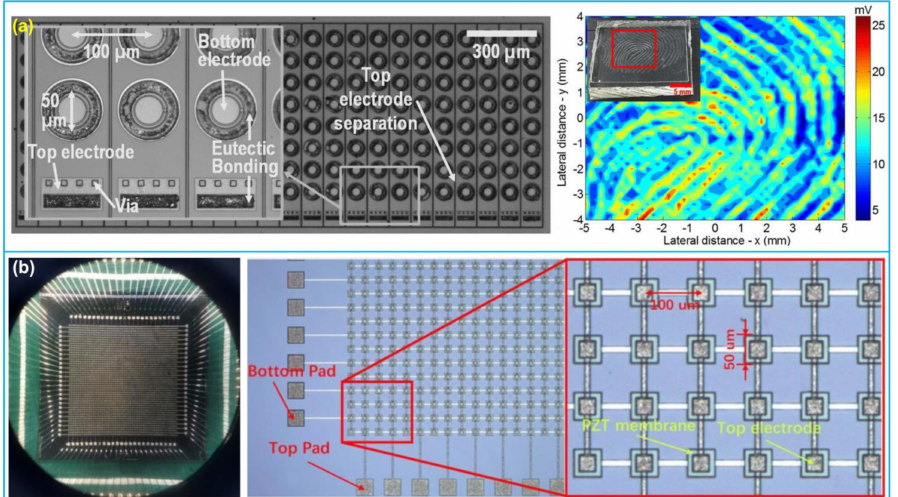
Figure 8. ( a ) 24 × 8 PMUT array and 2D ultrasonic image of the PDMS fingerprint phantom; ( b ) 50 × 50 PMUT array and chip. ( a ) Reprinted from Ref. [139] with permission; ( b ) reprinted from Ref. [64] with